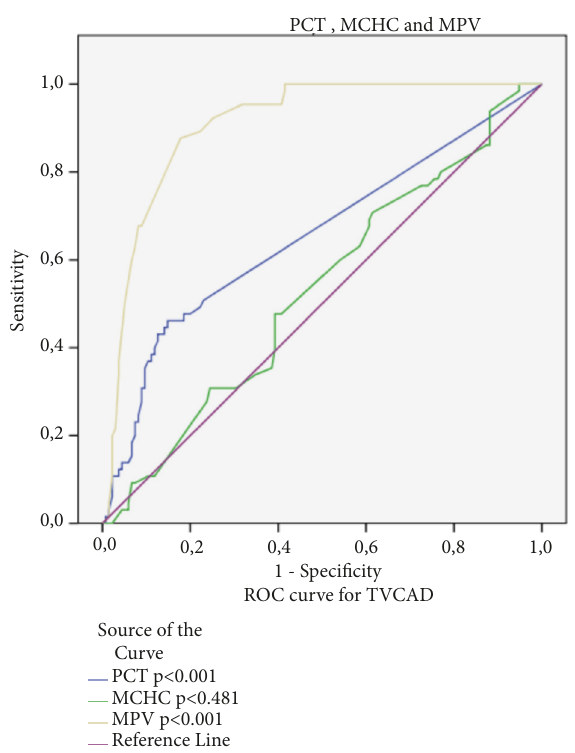
Figure 2: ROC curve analysis according to PCT, MCHC, and MPV TVCAD